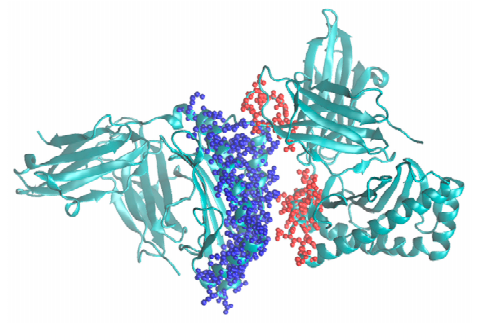
Figure 3. Crystal structure of MHC class I HLA-A2.1 bound to a photocleavable peptide (PDB ID: 2X70). The possible choices of flexible parts corresponding to F 1 and F 2 are shown in red and blue spheres, respectively.